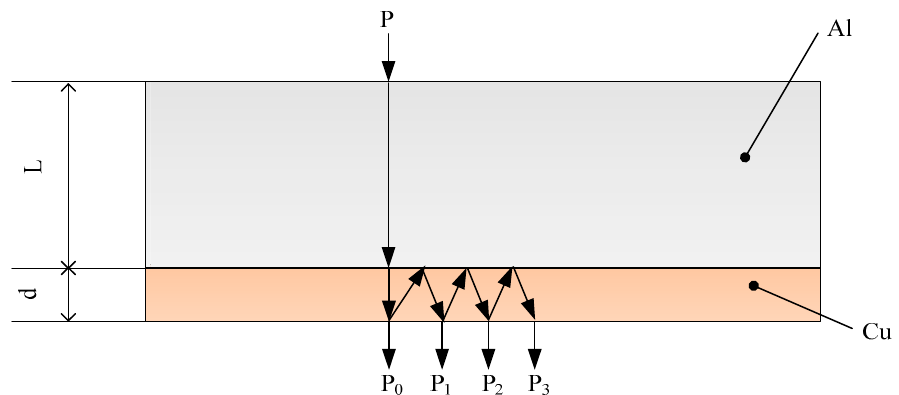
Figure 1. The ultrasonic propagation model of pulse transmission method.